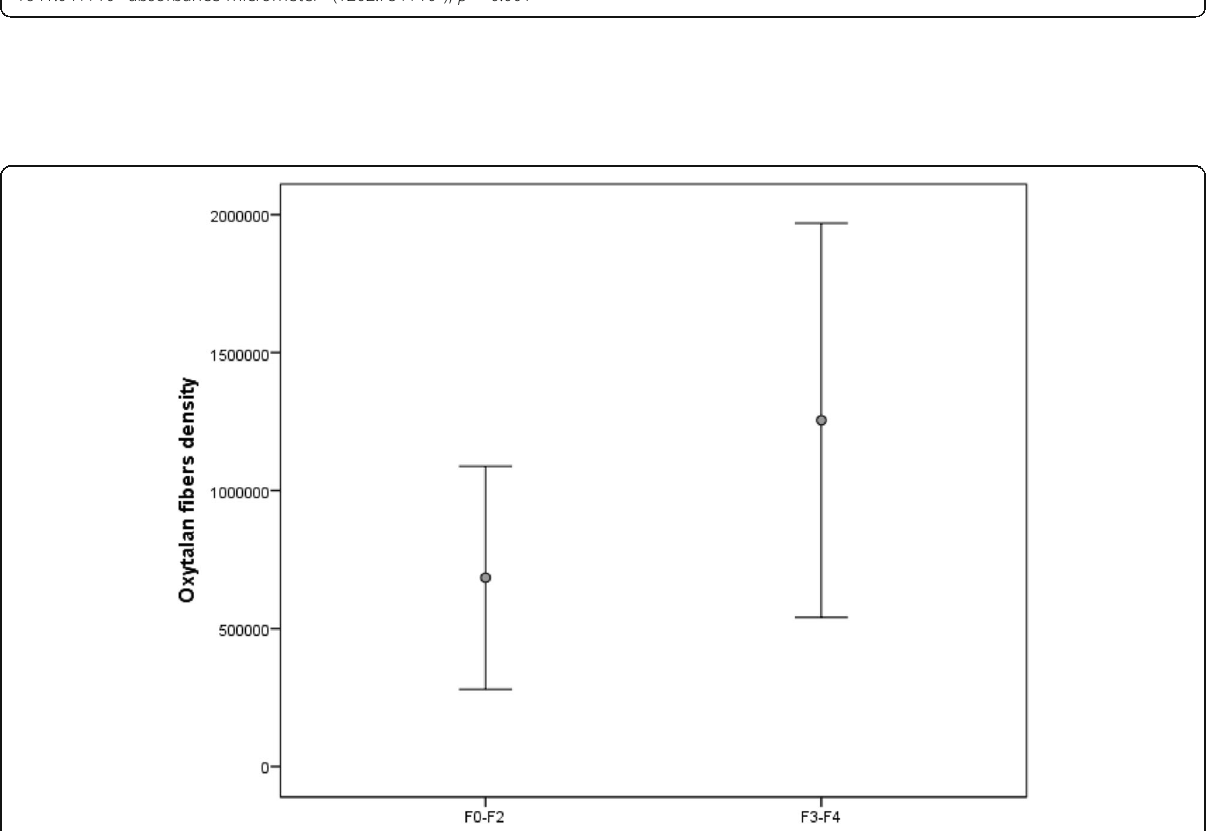
Fig. 3 Oxytalan fibers density in groups of early and advanced fibrosis. F0-F2: 683.87 × 10 3 absorbance-micrometer 2 (404.35) X F3-F4: 1254.4 × 10 3 absorbance-micrometer 2 (714.08 × 10 3 ), p =